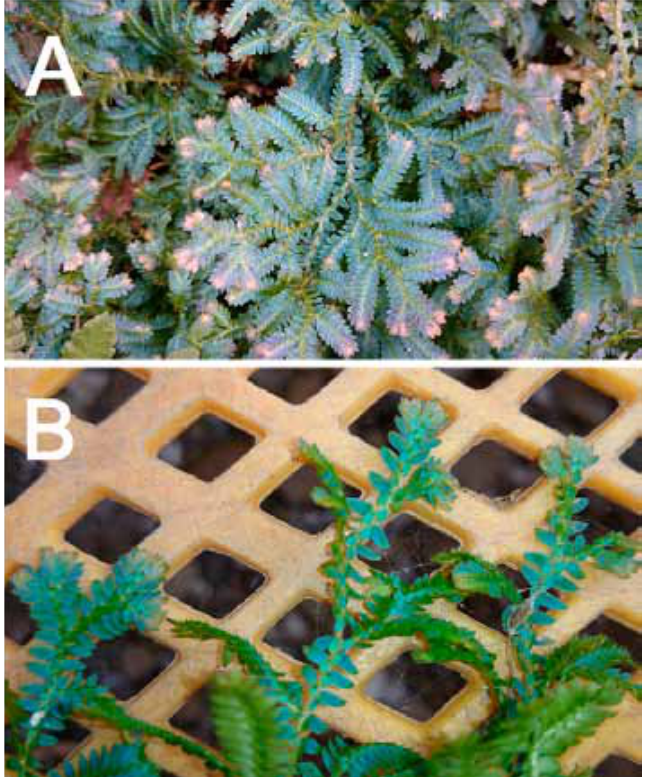
Fig. 1 - Living Selaginella remotifolia found in a private garden (Kiyo- take-cho, Miyazaki, Japan). (A) Sheet of growing Selaginella remotifolia covering the ground. (B) Blue-green colored